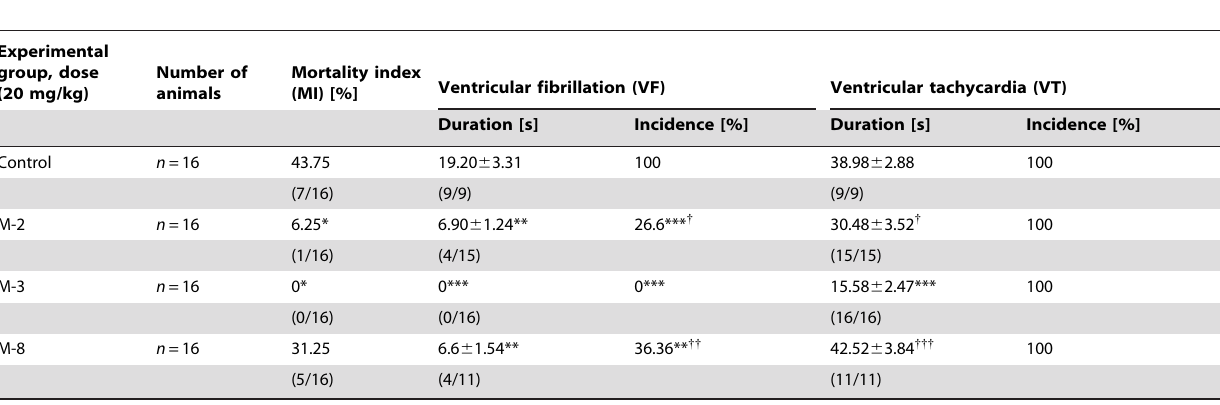
Data in parentheses are presented as the number of rats with MI, VT or VF/total number of rats in each group. Values are expressed as mean 6 SEM. The chi-square-test ( x 2) was used to estimate the significance between the incidence of arrhythmias and mortality in all comparisons. The Kruskal-Wallis test was used for others. Values marked with *( P , 0.05), **( P , 0.01) or ***( P , 0.001) are significantly different from control. Values marked with { ( P , 0.05), {{ ( P , 0.01) or {{{ ( P , 0.001) are significantly different from M-3 group.